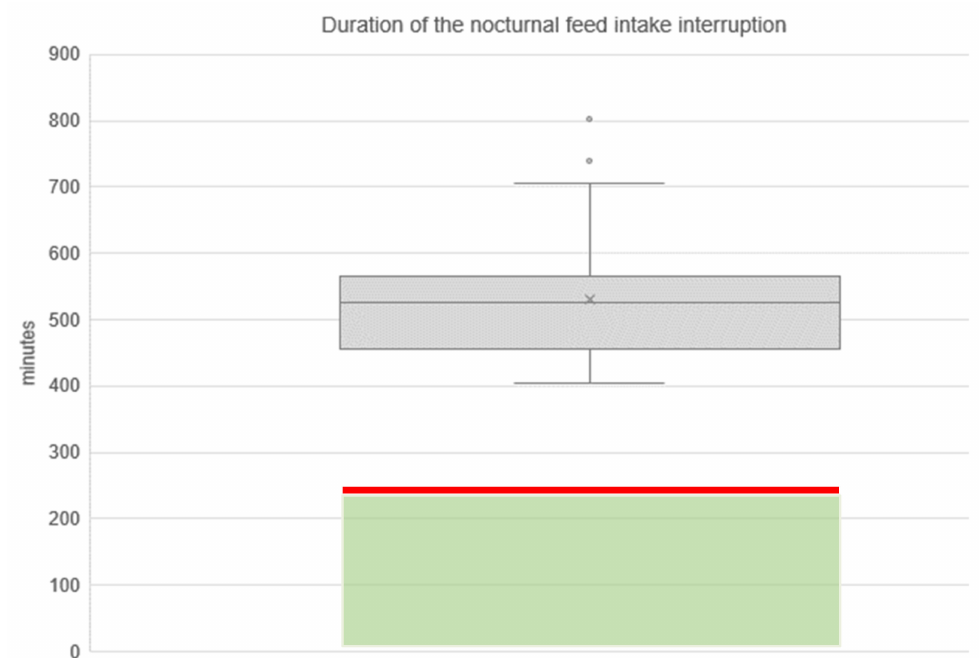
Figure 2. Duration of the nocturnal feed intake interruption of horses on shavings, which had finished their evening meal within the observation period (74.32%; n = 55 horses on shavings out of 74 horses on shaving in total). Green box: period without food supply which is still appropriate in terms of welfare; red line: tolerable maximum duration of feed intake interruptions at 240 min (4 hours) according to the German welfare standard